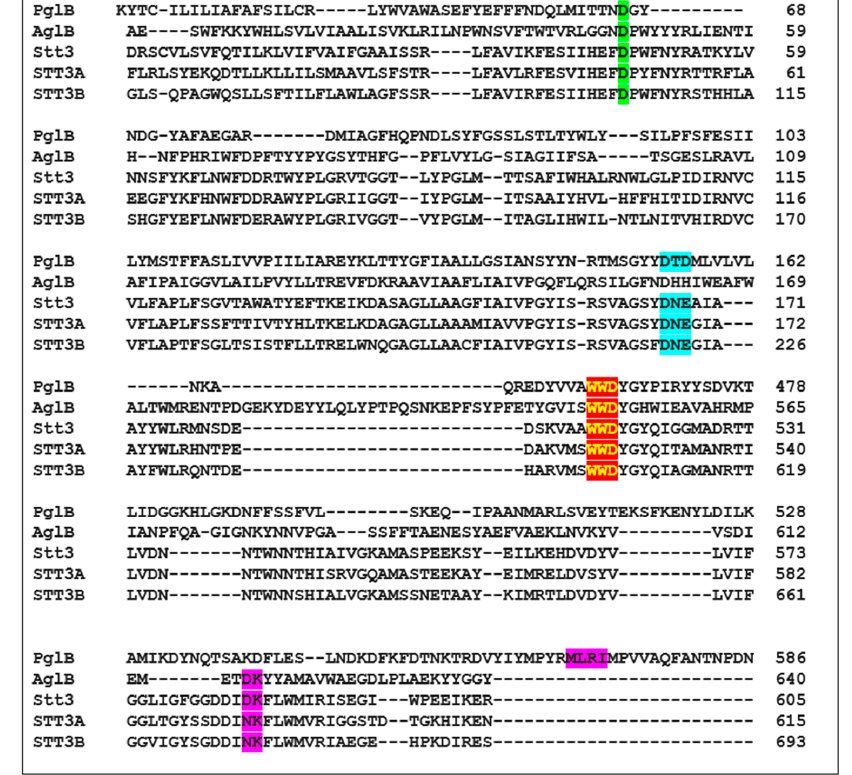
Figure 5. Sequence alignment of bacterial PglB, archaeon AglB, yeast Stt3, human STT3A, and human STT3B proteins to show the important residues and motifs. D56 (PglB), D47 (AglB and yeast Stt3), D49 (human STT3A), and D103 (human STT3B) are shown in green background. DXD motif in PglB, DXE motifs in yeast Stt3, human STT3A, and human STT3B are shown in cyan background. The conserved WWD motif is shown in red background highlighted in yellow. The MXXI motif in PglB that corresponds to DK motifs in AglB and yeast Stt3 are shown in purple background.